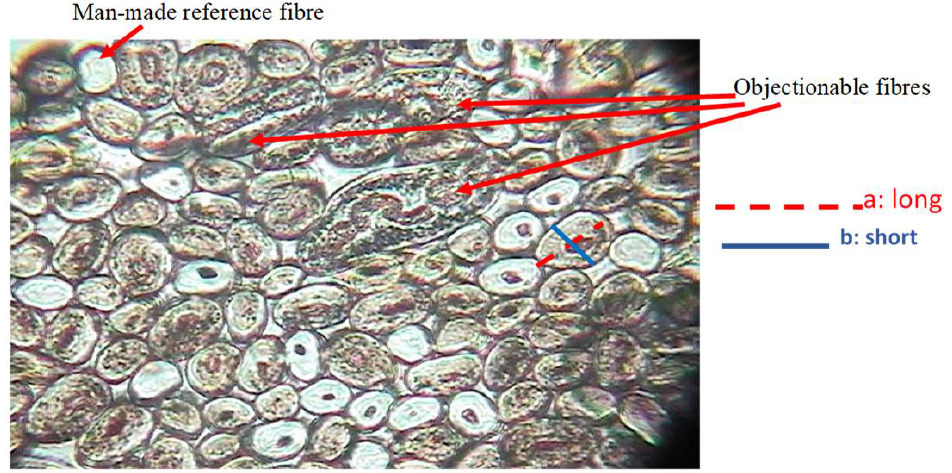
Figure 1. A microscopically pictured cross-section of the fibre sample with measurement indica- tions as the a and b